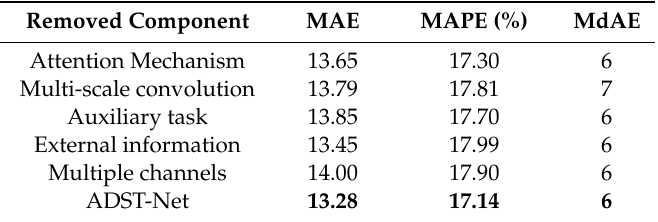
Table 7. The evaluation results of Self-comparison